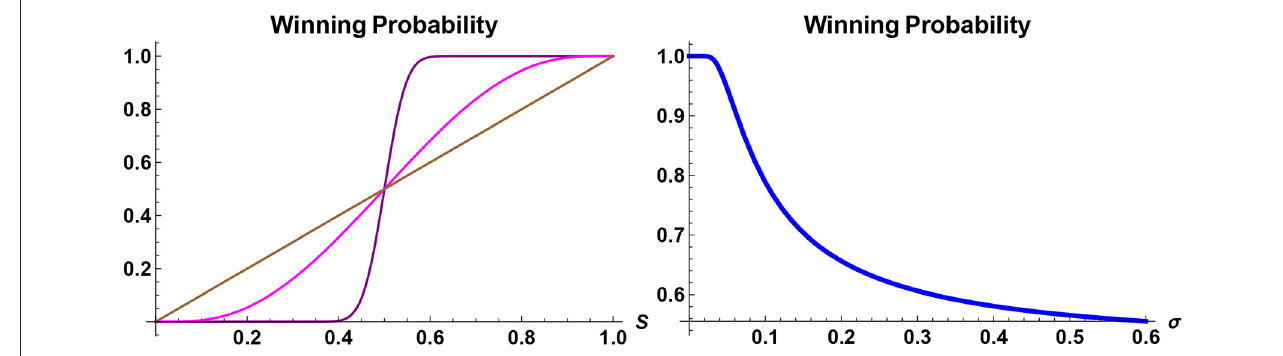
FIGURE 2 | Probability of winning a future election. The winning probability of a candidate in a two-candidate electoral competition, to take place in 1 year time, is plotted. On the left panel, the probabilities are shown as a function of today’s support rating S for two different values of the information-flow rate: σ and σ 0.95 (magenta). If today’s poll S were an indicator for the winning probability, then it would be given by a straight line (brown), but in reality the probability of = winning a future election of a candidate, whose current support rate is S > 50 % , is always greater than S . On the right panel, the winning probability is shown as a function of the information-flow rate σ of a candidate whose support rate today is S little information relevant to the election as